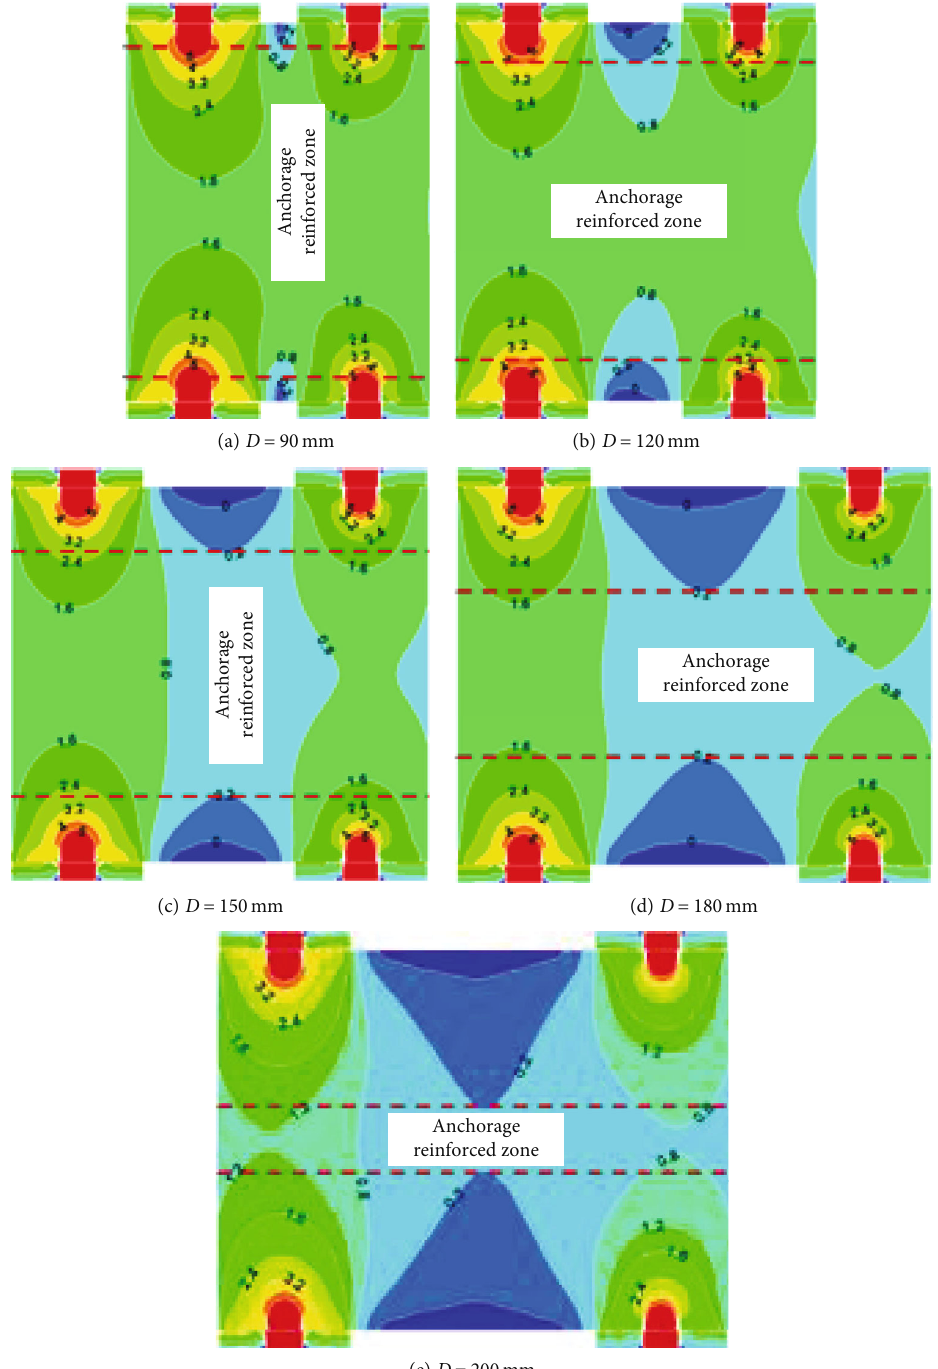
Figure 14: Anchorage stress distribution of rock mass specimen with di ff erent bolt